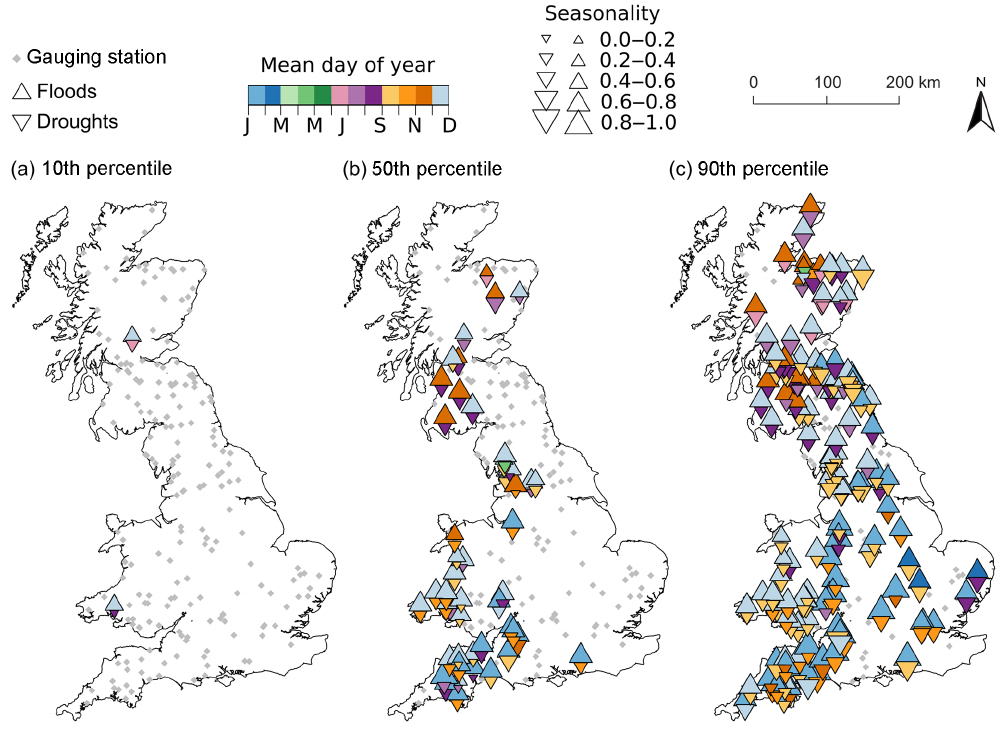
Figure 8. Time of year (mean day of year in colour scale and seasonality in size scale) of the hydro-hazards for the hot-spots in Great Britain in the 2080s for the (a) 10th, (b) 50th, and (c) 90th